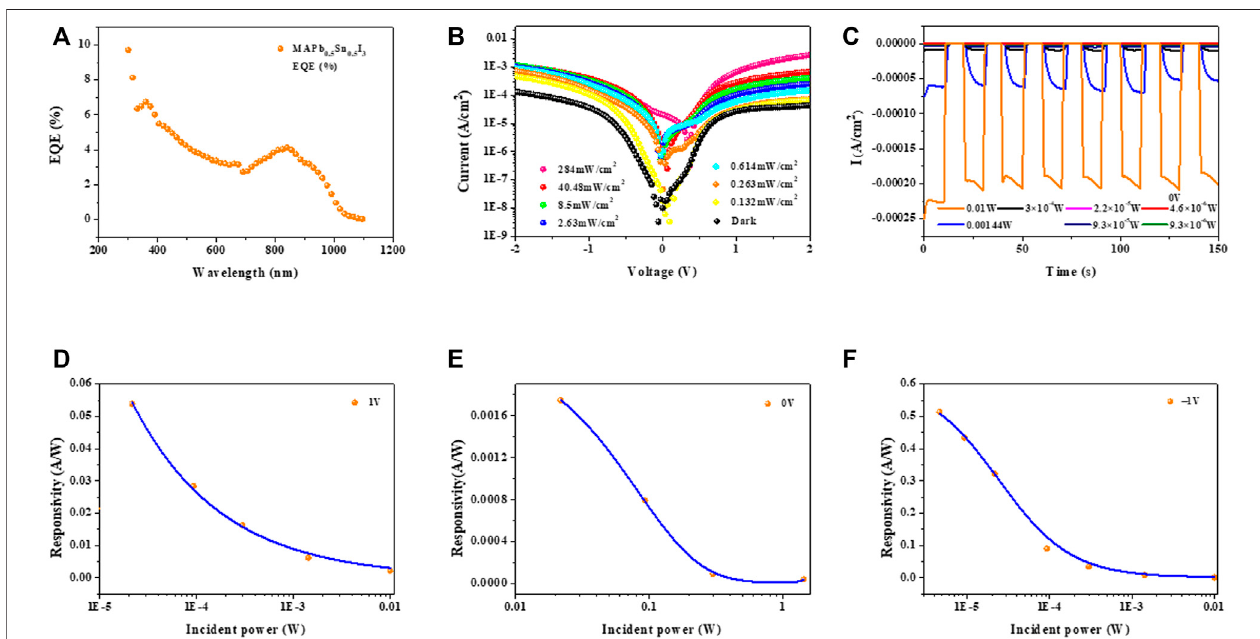
FIGURE 6 | (A) EQE curves of MAPb 0.5 Sn 0.5 I 3 single-crystal devices under zero bias. (B) Current – voltage curves of a MAPb 0.5 Sn 0.5 I 3 single-crystal devices under 905 nmnear-infraredlightilluminationanddark.Asingle-crystalthin fi